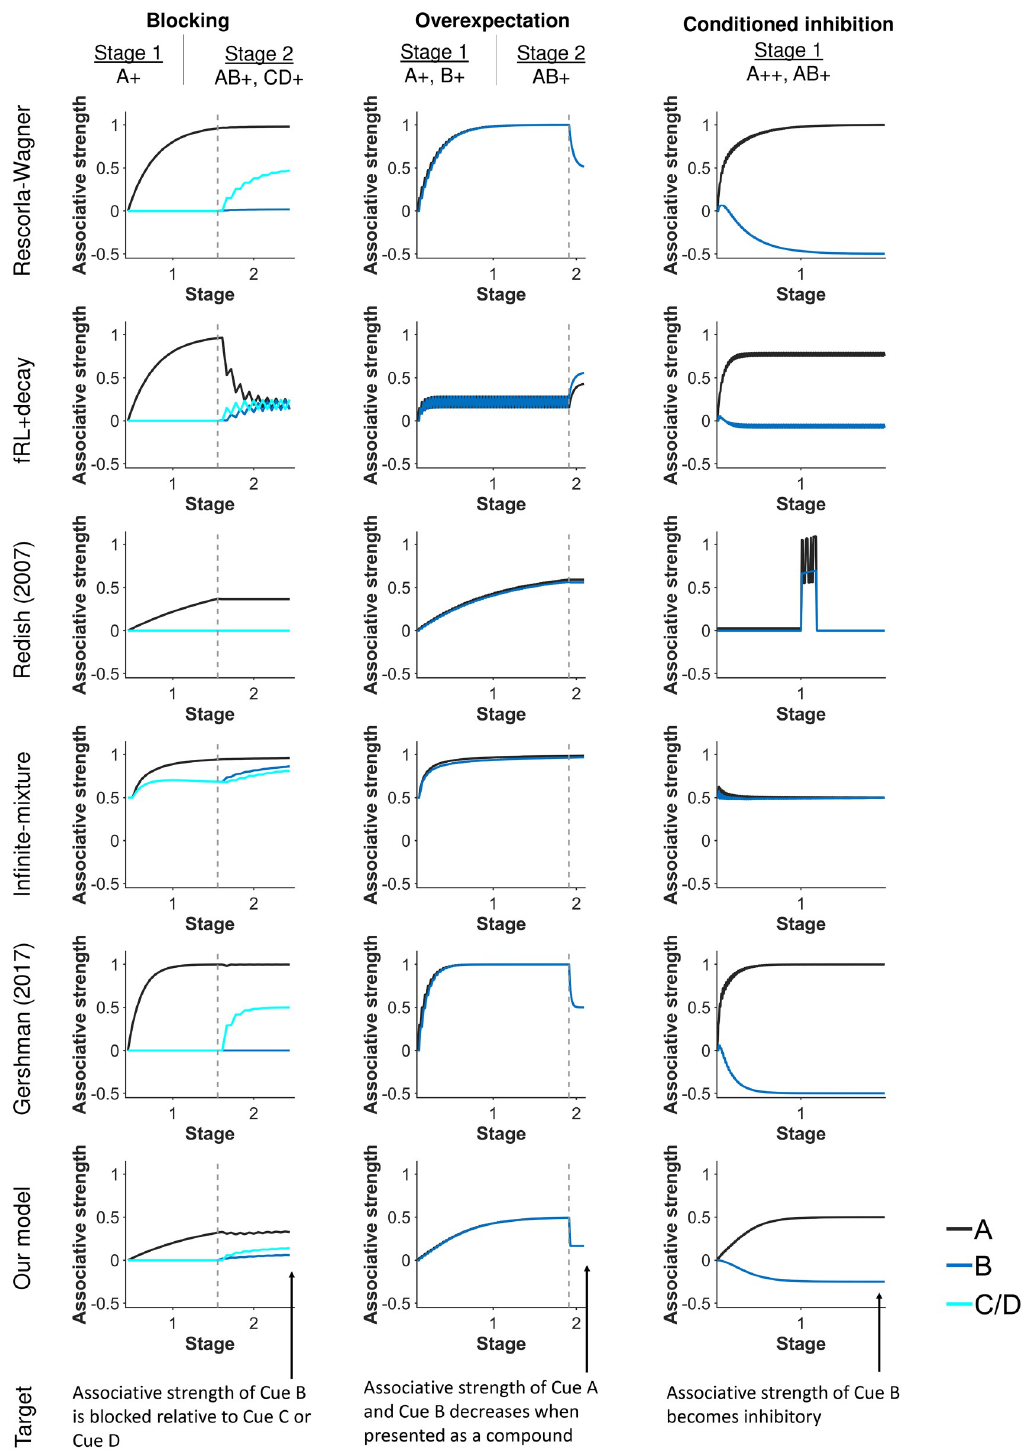
Fig 2. Simulated associative strengths of cues during blocking, overexpectation, and conditioned inhibition experiments, which the Rescorla-Wagner (RW) model famously could explain. Built upon the RW model, our latent-state model and the Gershman (2017) model can also explain these experiments. Gray dashed lines demarcate experimental stages.